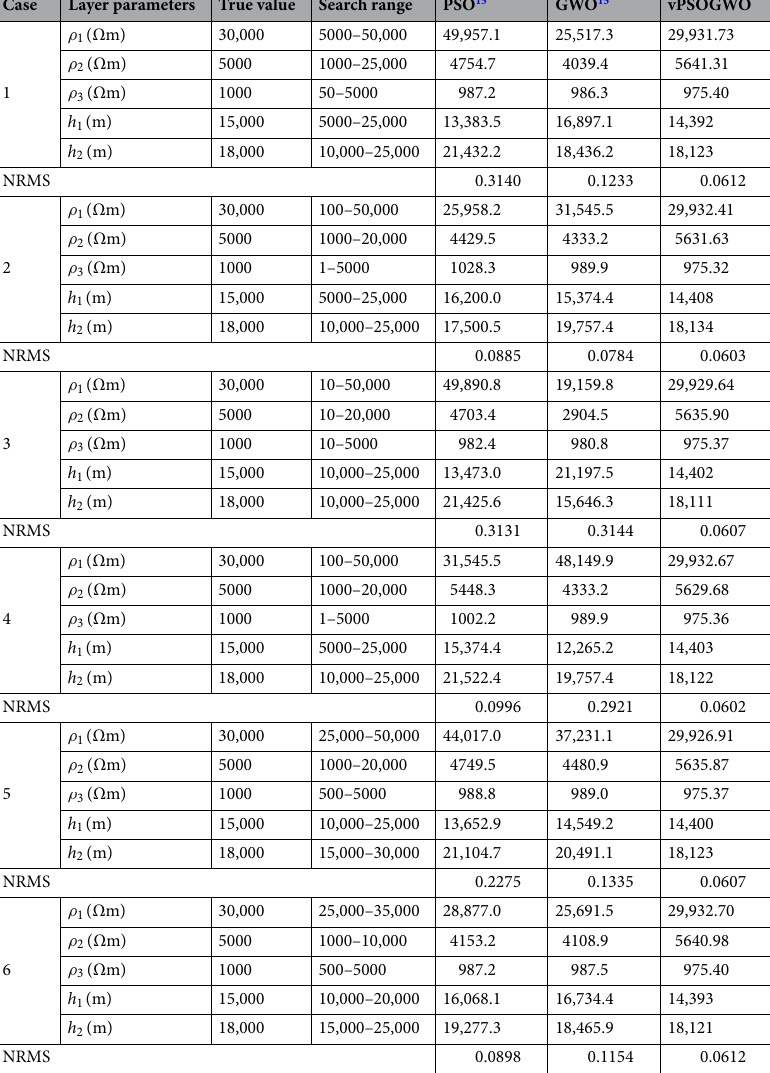
Table 4. Stability and sensitivity of 10% noisy synthetic MT